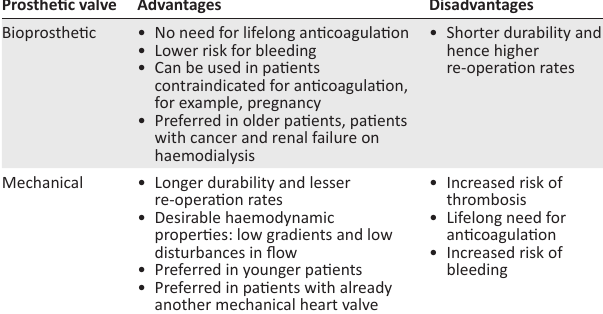
TABLE 3: Bioprosthetic and mechanical heart valves: advantages and disadvantages. Prosthetic valve Advantages